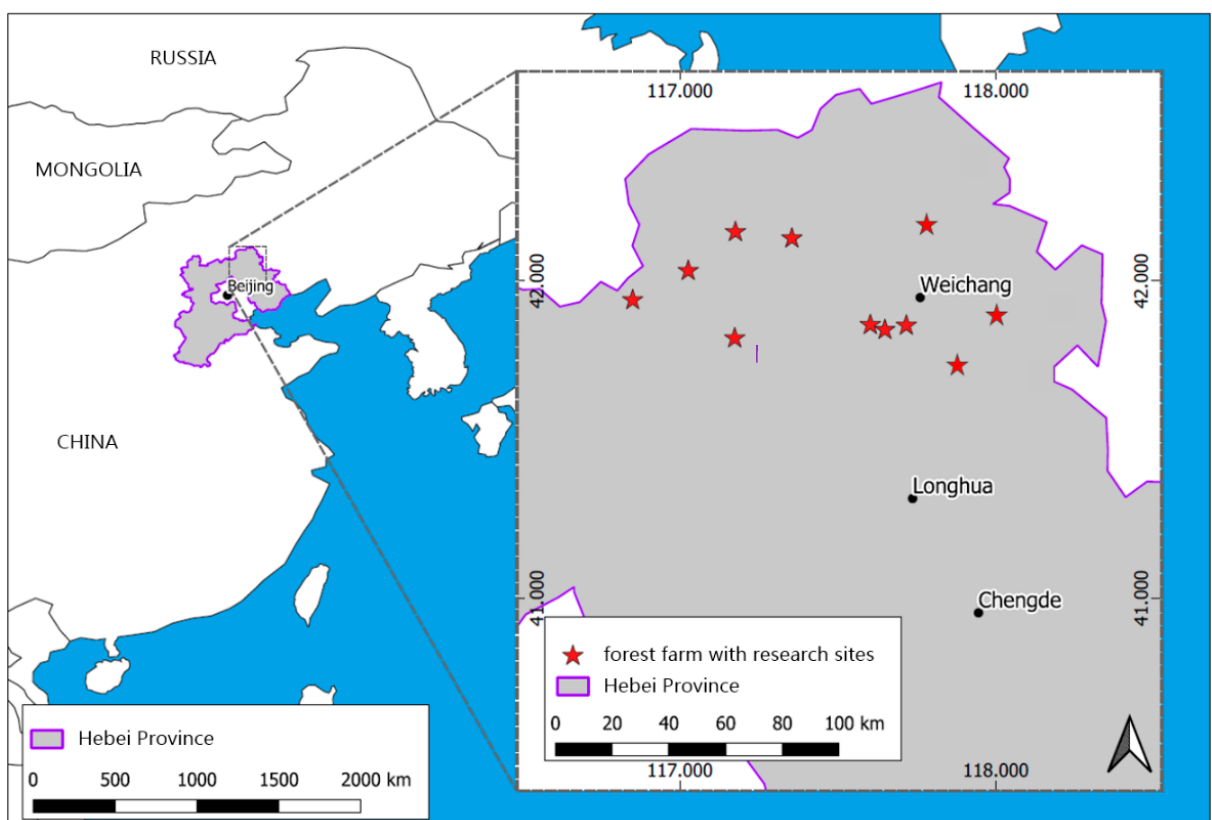
Figure 1. Geographic map with the location of the forest farms and the research sites in Mulan Forest (d-maps.com (accessed on 3 February 2021); modified).